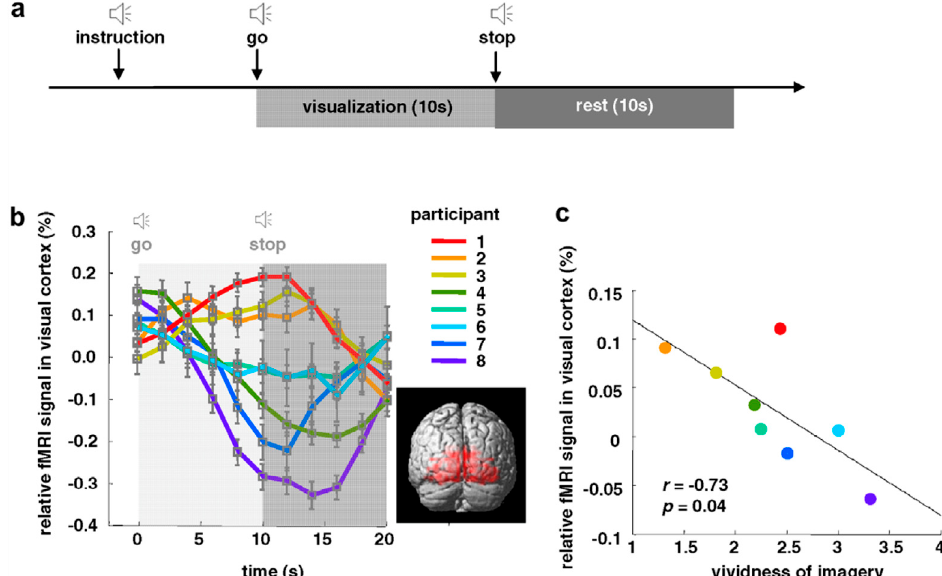
Figure 5. Relative activity in visual cortex correlates with subjective vividness rating. ( a ) Timeline of the visualization task. Participants began to visualize upon hearing the ‘go’ signal and stopped visualization upon hearing the ‘stop’ signal, resulting in a 10-s visualization phase and 10-s rest phase. All instructions were auditory. ( b ) Time course of the relative fMRI signal in visual cortex for 8 participants. Relative fMRI was taken as the BOLD signal in early visual cortex (Brodmann’s areas 17 and 18, illustrated in inset) minus the BOLD signal measured over all of grey matter. For plotting purposes, participants are ordered by their relative visual cortex activity averaged over the visualization window of 0–10 s. The negative signal for some subjects is due in part to the subtraction of the whole brain activity—i.e., other regions can increase more than the visual cortex during the time window. ( c ) The relative visual cortex signal averaged over the visualization window correlates significantly with the subjective rating of vividness ( p = 0.04). Reprinted with permission from ref. [25]. 2005. X. Cui et al. Note that there were only 8 participants in this study, and the p level for the correlation was only 0.04. The 5 subjects with the most vivid visual imagery produced positive relative fMRI signals in the visual cortex. Other studies have obtained different results